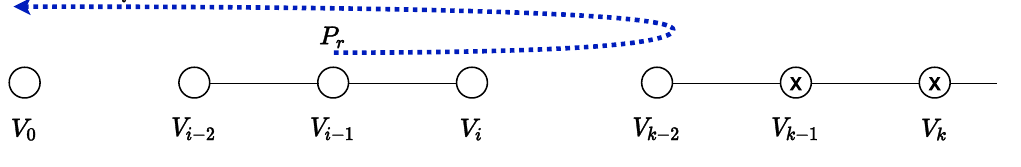
Figure 8. Flow Pr interrupted.